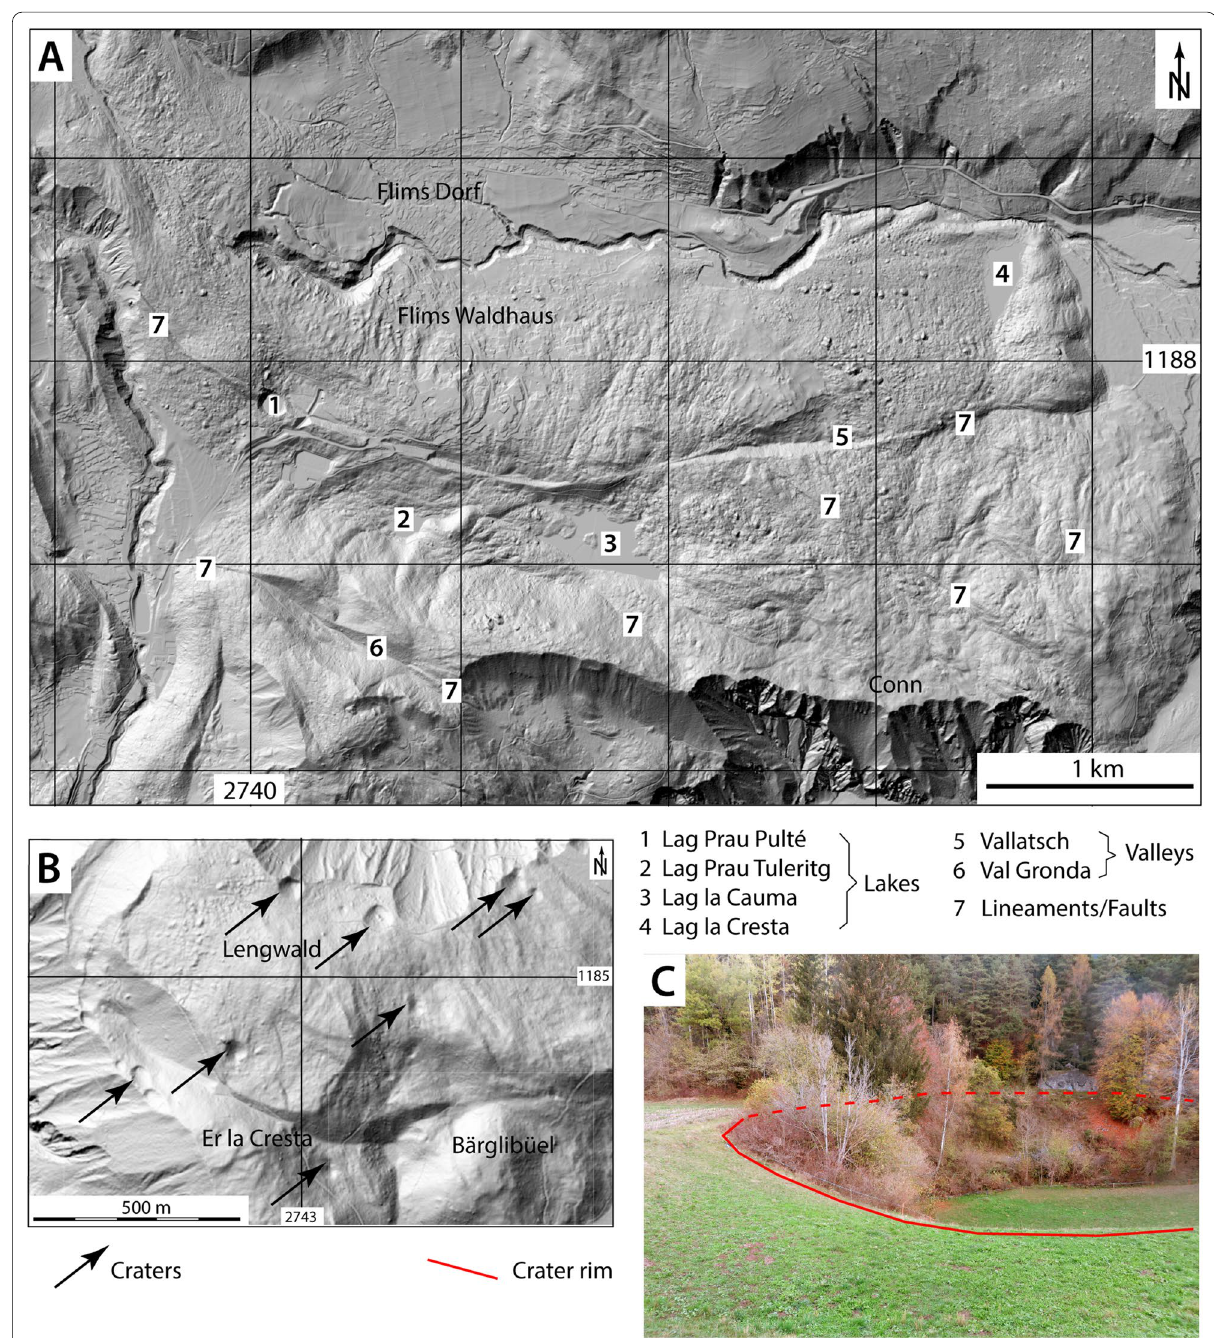
Fig. 11 Morphology of the rock avalanche deposit. A Digital elevation model of the area Flims—Conn showing four lakes lacking surface inflow, and faults indicated by lineaments or valleys. B Digital elevation model of the area south of Vorderrhein displaying several craters that stem from blow-out pipes. C Photograph of a blow-out crater at Laséaz (coord. 2745.800/1187.335). Photo A.